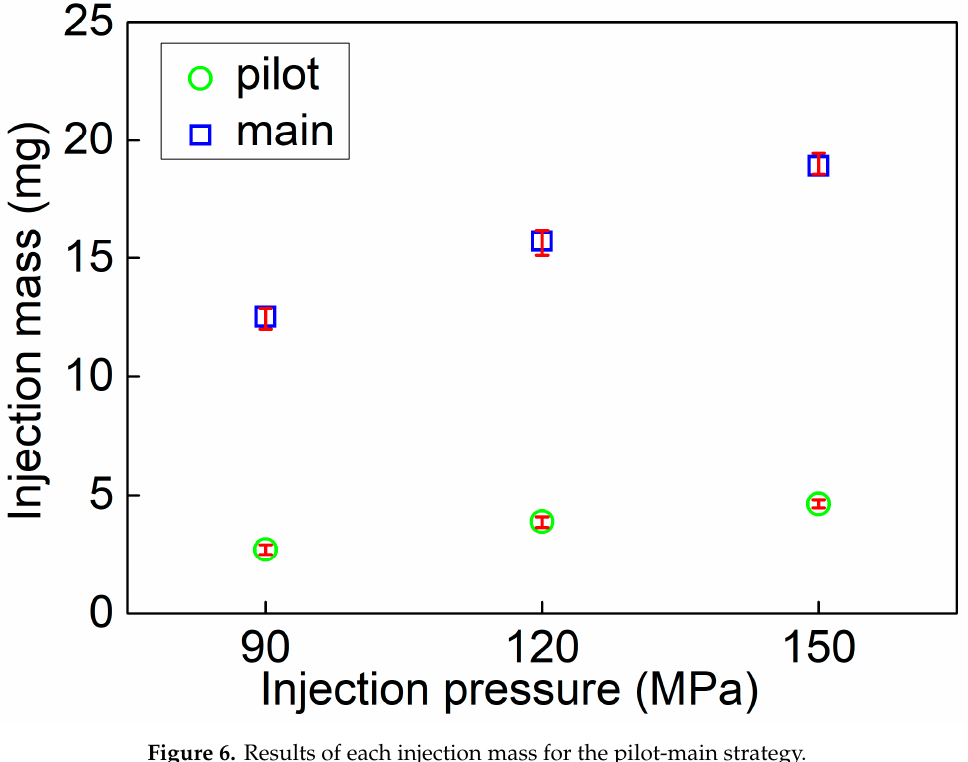
Figure 6. Results of each injection mass for the pilot-main strategy.